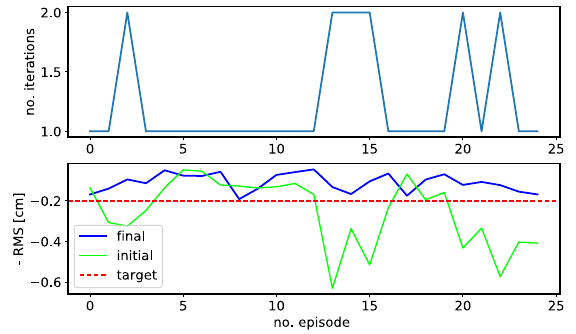
FIG. 8. Short validation run after training with 200 episodes